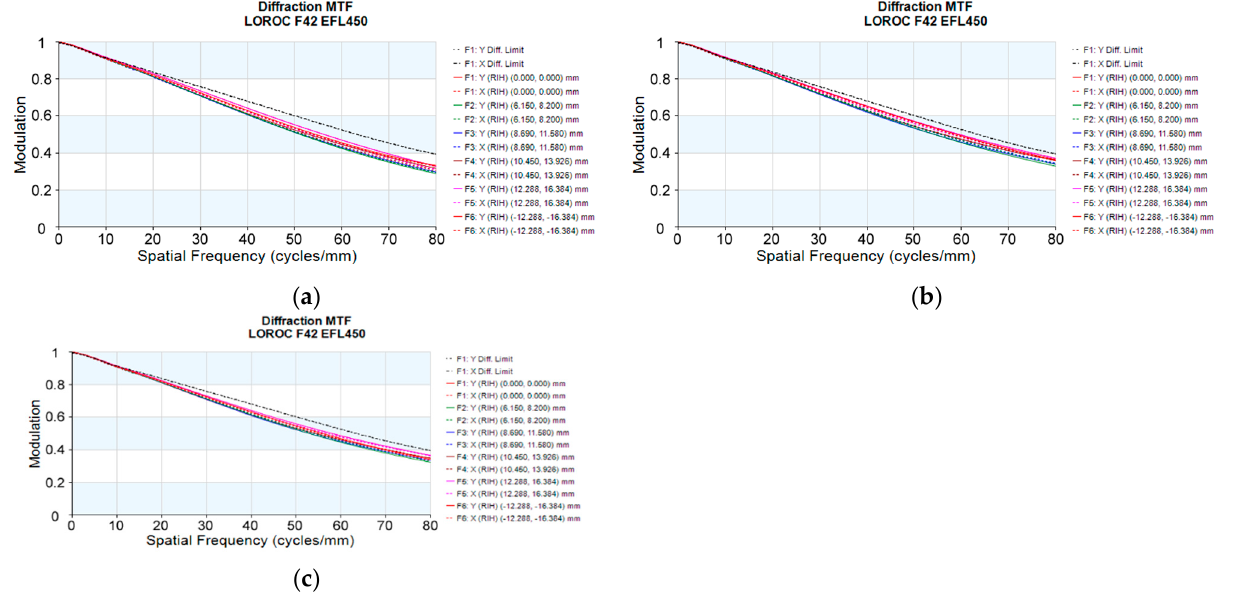
Figure 4. Corresponding MTF performance of the oblique airborne-mapping camera at different temperatures: ( a ) − 40 °C; ( b ) +20 °C ; ( c ) +60 °C . temperatures: ( a ) − 40 ◦ C; ( b ) +20 ◦ C; ( c ) +60 ◦ C.